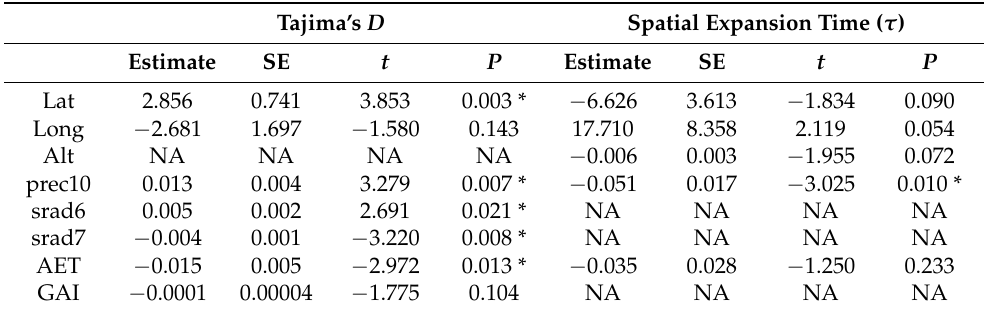
Table 4. Summary results of the generalized linear model for testing significant factors in the extent of demographic dynamics (Tajima’s D ) and spatial expansion time ( τ ). Tajima’s D Spatial Expansion Time ( τ ) Estimate SE t P Estimate SE t P Lat 2.856 0.741 3.853 0.003 * − 6.626 3.613 − 1.834 Long − 2.681 1.697 Alt NA NA NA NA − 0.006 0.003 − 1.955 prec10 0.013 0.004 3.279 − 0.051 0.017 − 0.004 0.001 − 3.220 0.008 * NA NA NA